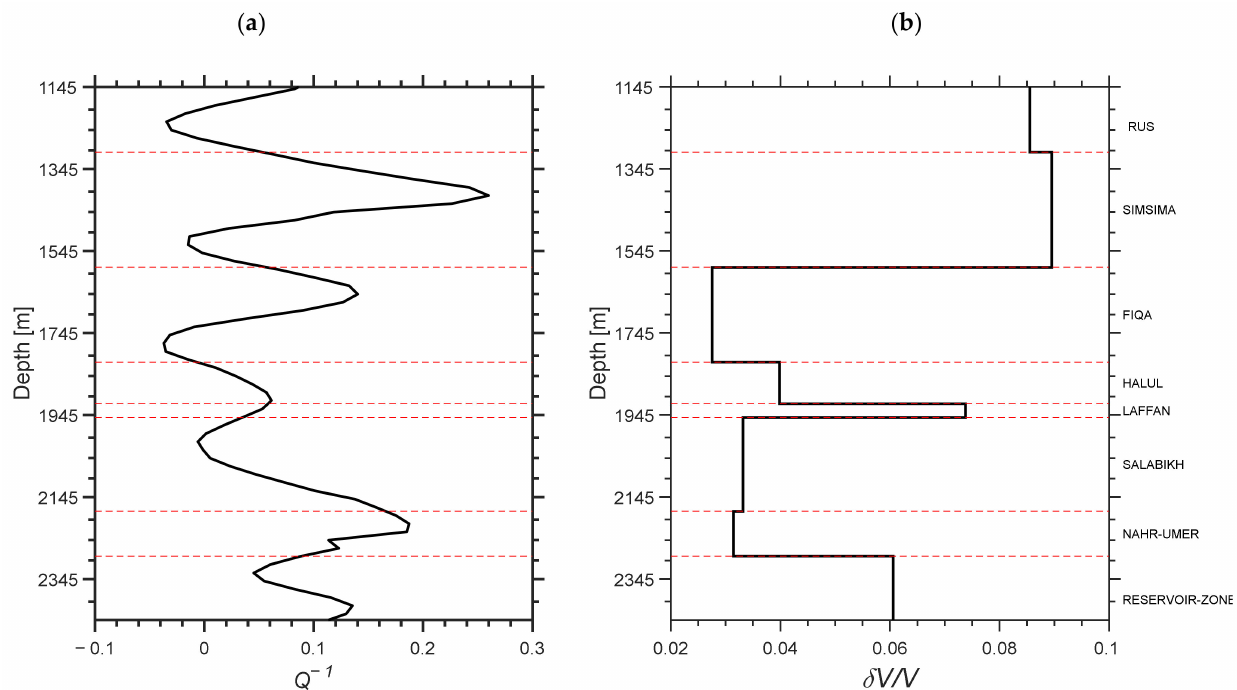
Figure 11. ( a ) Scattering and ( b ) the relative variation of velocity. The dashed horizontal lines and the text labels indicate the tops and names of the various geological formations